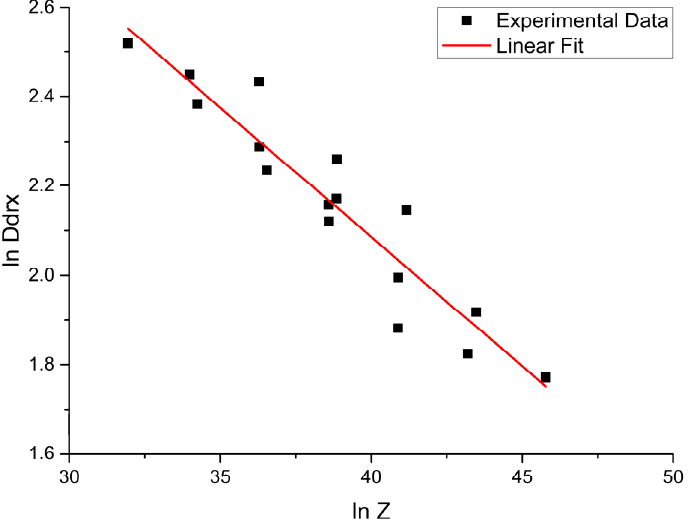
Figure 7. ln D drx — lnZ . Figure 7. ln 𝐷 (cid:3031)(cid:3045)(cid:3051) — 𝑙𝑛𝑍 . The recrystallized grain size of 2A12 aluminum alloy can be calculated as Equation (13) by bringing the fitted values into Equation (9) after a linear fit to Figure 7.